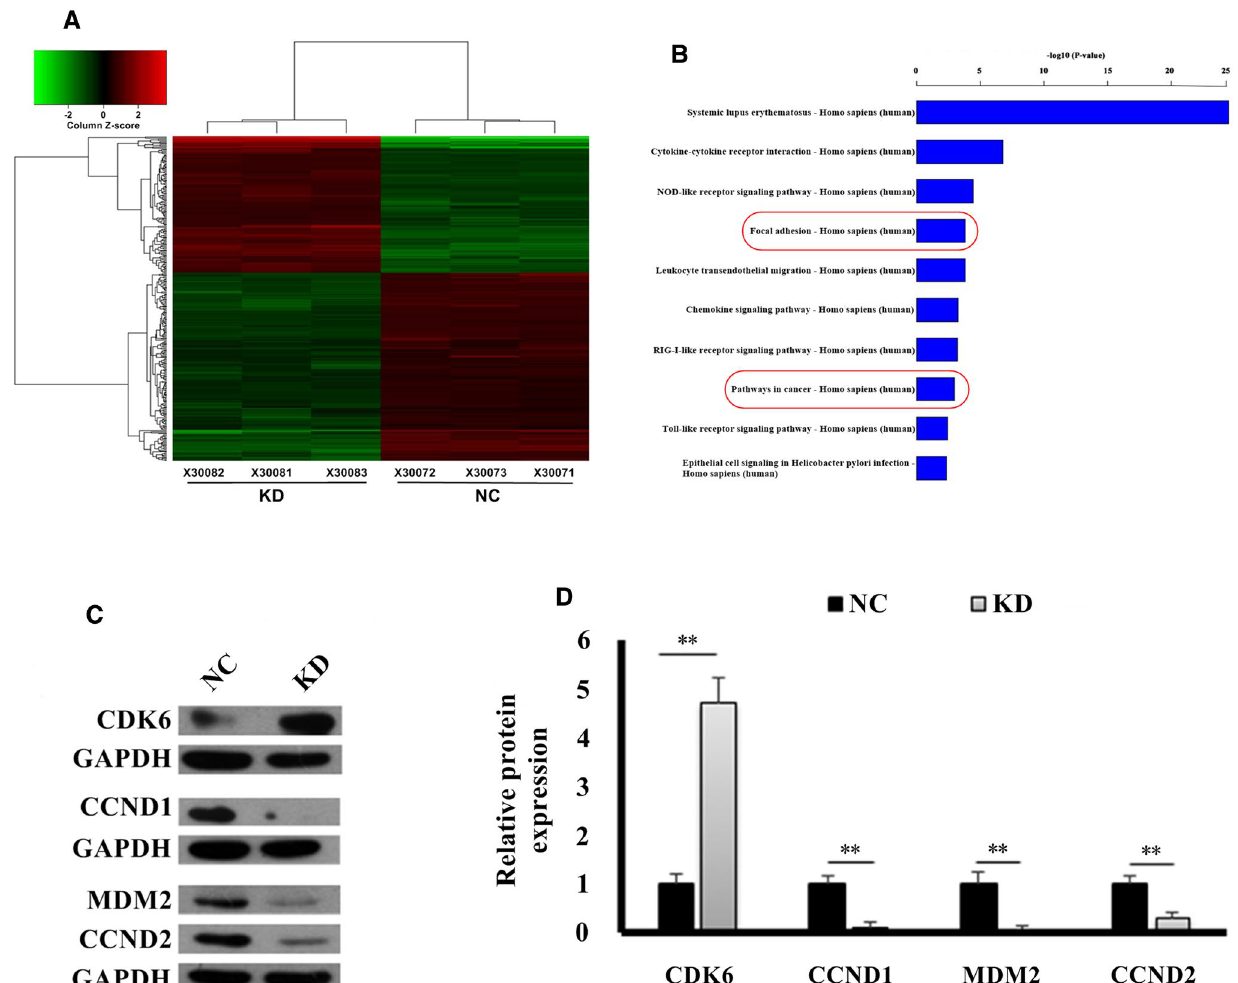
Fig. 6 Cyclin D Pathway Dysregulation Induced by PAIP1 Knockdown . A Cluster analysis of miRNA expression in PAIP1-knockdown (KD) and negative control (NC) SMMC-7721 xenograft tumor cells. Each row represents a unique miRNA, and each column represents an individual tumor sample (n = 3 tumors in each group). Red or green coloring represents elevated or decreased expression, respectively. B Results of the KEGG pathway analysis showing the top ten highest-ranking KEGG pathways. The ‘focal adhesion’ and ‘pathways in cancer’ pathways have been circled in red. C Representative Western blots of four key cyclin D pathway genes. GAPDH served as loading control. D The relative expression of each protein is graphically displayed. Results are displayed as means and standard deviations (SDs) from three independent experiments. * P < 0.05, ** P <